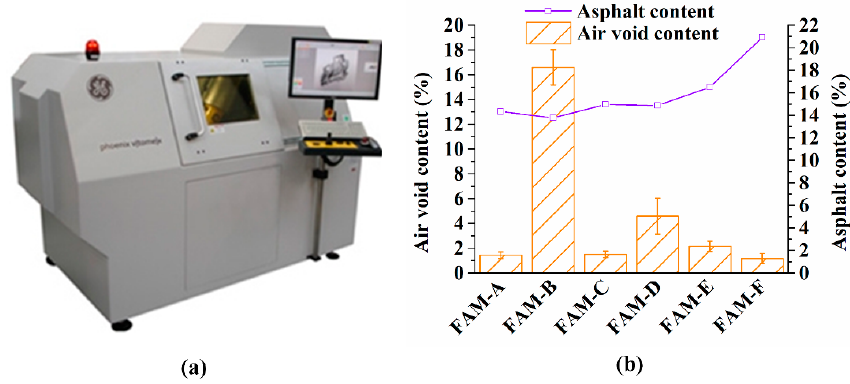
Figure 7. Air void in FAM: ( a ) Phoenix v|tome|xs ICT with micro focus, and ( b ) the air void content and the asphalt content in FAM.